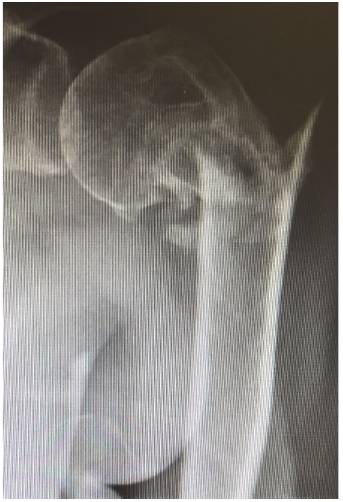
Figure 1: Preoperative radiograph depicting a two-part fracture of theproximalhumerus. Notethevarusmalalignmentoftheheadand lateral bone